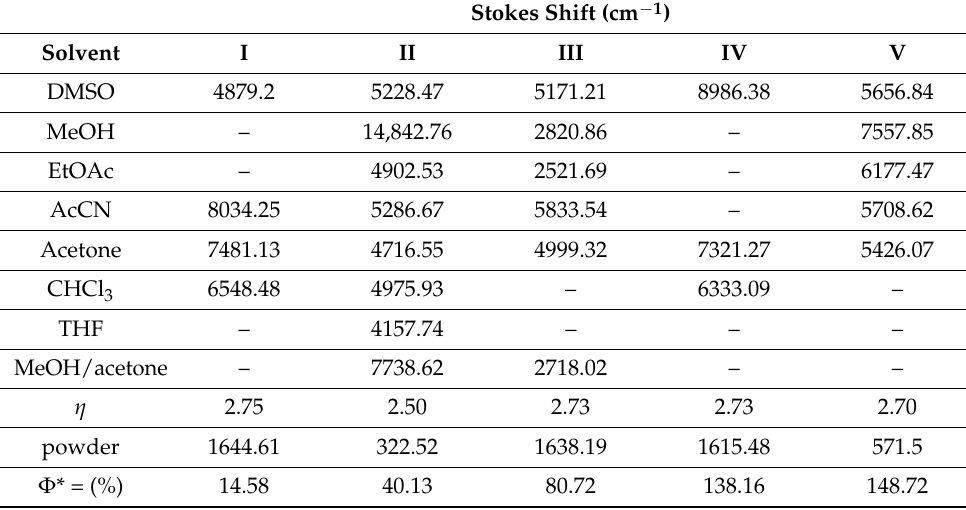
Table 2. Stokes Shift (cm − 1 ) in solution, solid state, and quantum yield in solid state of I – V .